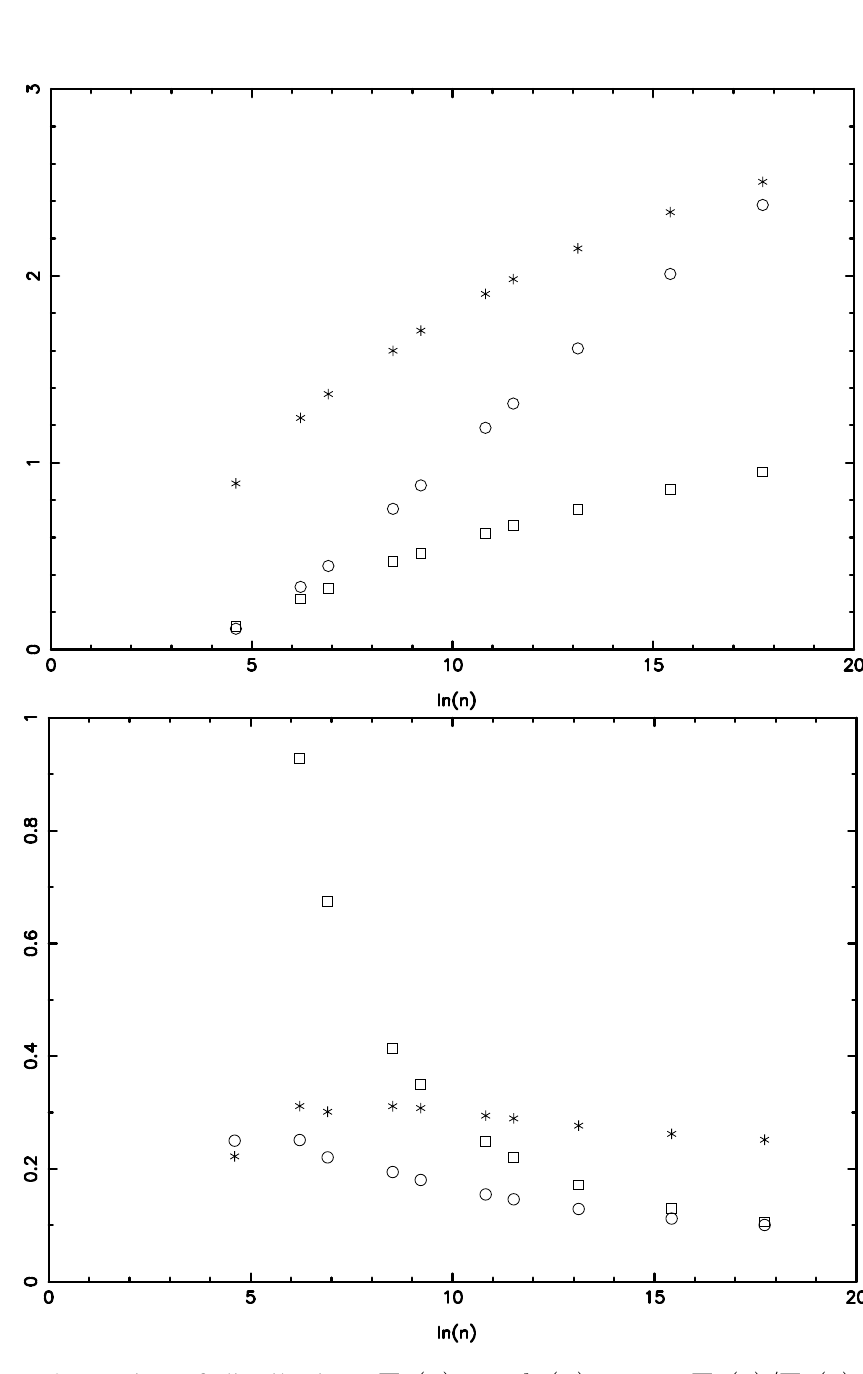
Figure 8: Ratios of distributions Π (3) / Π (0) circle, Π isk, Π n n Π (2) / Π (1) circle, Π n n